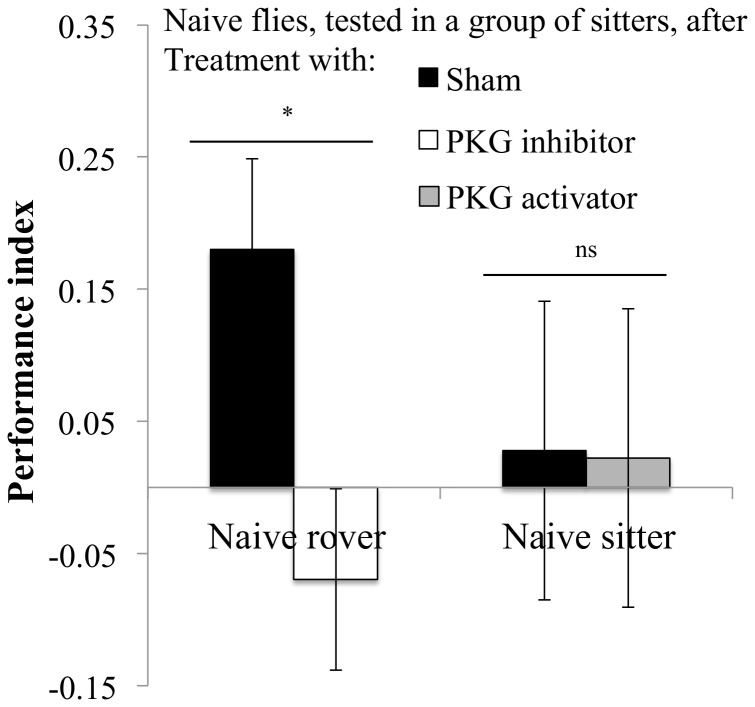
Performance of individual naïve flies after pharmacological manipulation when placed into groups of conditioned flies during the test.Rover: Sham: PI = −0.18±0.06 N = 11 PI; PKG inhibitor: PI = −0.07±0.07 N = 11 PI. Sitter: Sham: PI = 0.02±0.11 N = 9 PI; PKG activator: PI = 0.02±0.08 N = 12 PI. Error bars represent ±SEM. Comparison between treatments. ns: P>0.05; *: P<0.05; **: P<0.01; ***: P<0.001.